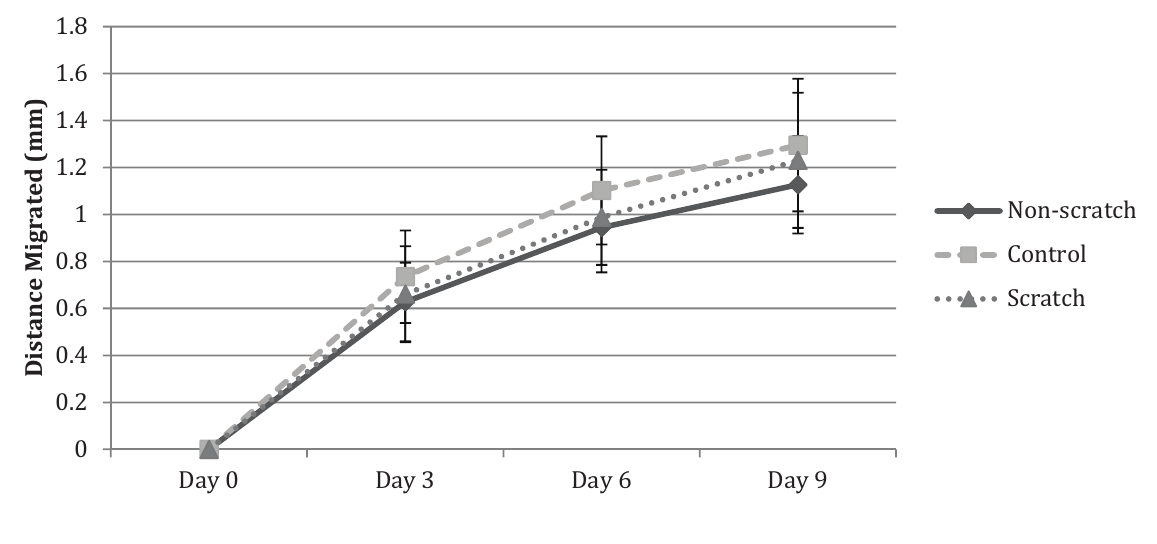
Figure 7. Three-dimensional wound migration assay. Fibroblast migration from collagen to a fibrin defect with two medium conditions (non-scratch and scratch). Distance migrated measured in ImageJ as the distance between the wound edge and the leading edge of cell